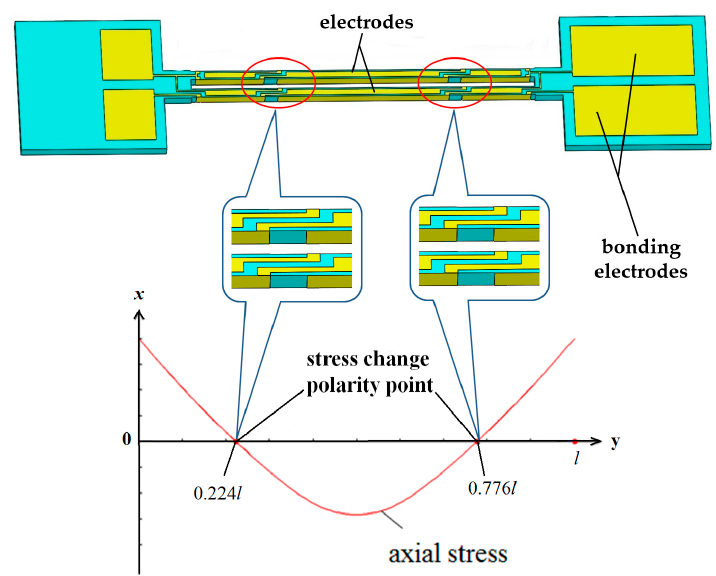
Figure 2. Diagrammatic sketch of the DETF.